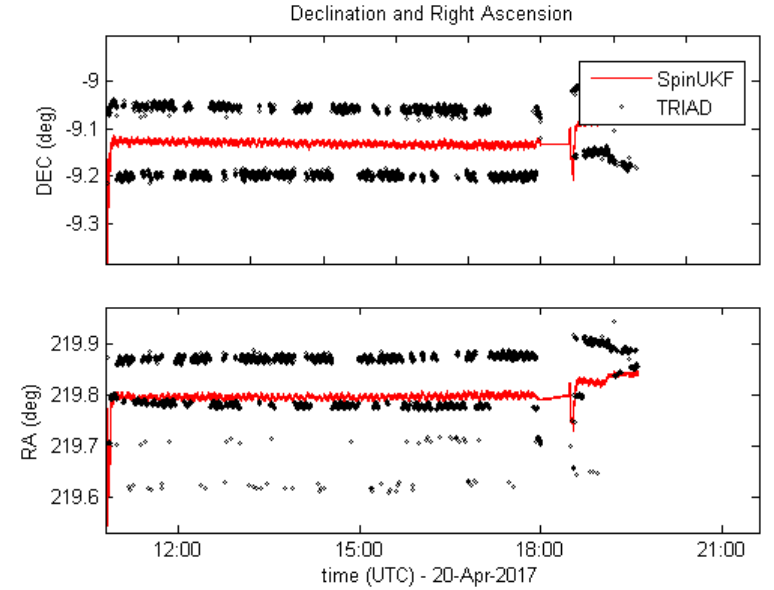
Figure 12. Fine spin-axis estimation by the SpinUKF and TRIAD on 20 April 2017 from 11:00 to 20:00 UTC. SpinUKF estimates are for principal Z axis incorporating the SAT correction.